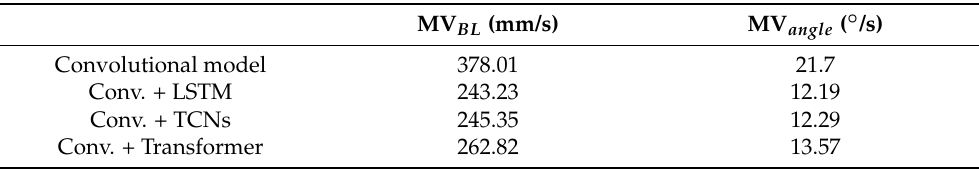
Table 4. The mean velocity errors for bony landmarks MV BL and joint angles MV angle , lower values indicate smoother estimations. Adding a sequential model most probably improves the continuity of